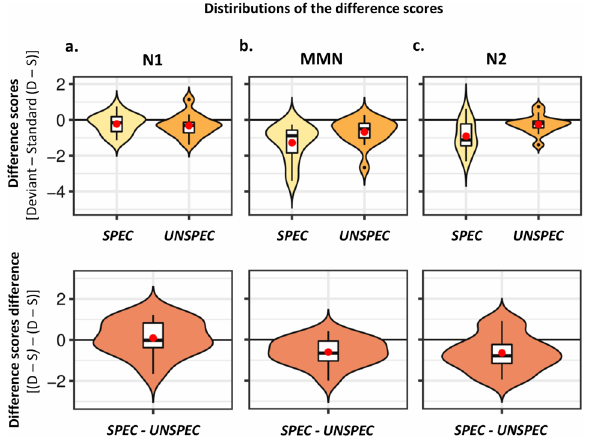
Figure 4. Difference scores. Violin plots display the condition-specific distributions for the difference scores (deviant—standard, top) and for the differences between conditions regarding the observed mismatching effects (deviant—standard differences between conditions, bottom) for the N1 ( a ), MMN ( b ), and N2 ( c ) components. The estimated density distributions are shown along with boxplots indicating the medians, interquartile ranges, and confidence intervals, whereas the means are displayed by the red dots. The black dots represent individual data points falling outside the confidence intervals. Figure generated in R, version 3.5.1 (https:// cran.r- proje ct. org/), in combination with the “ggplot2” package (https:// ggplo t2. tidyv erse. org/).